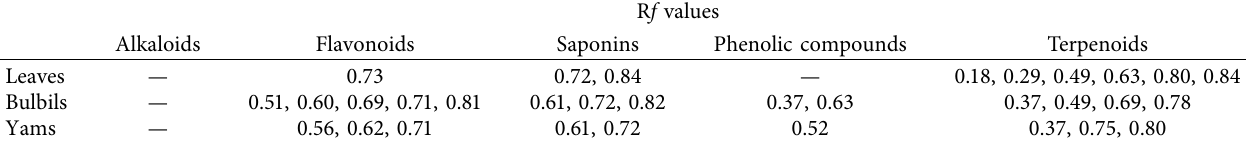
Table 1: R f values of chemical compounds found in leaves, bulbils, and yams of Dioscorea sansibarensis